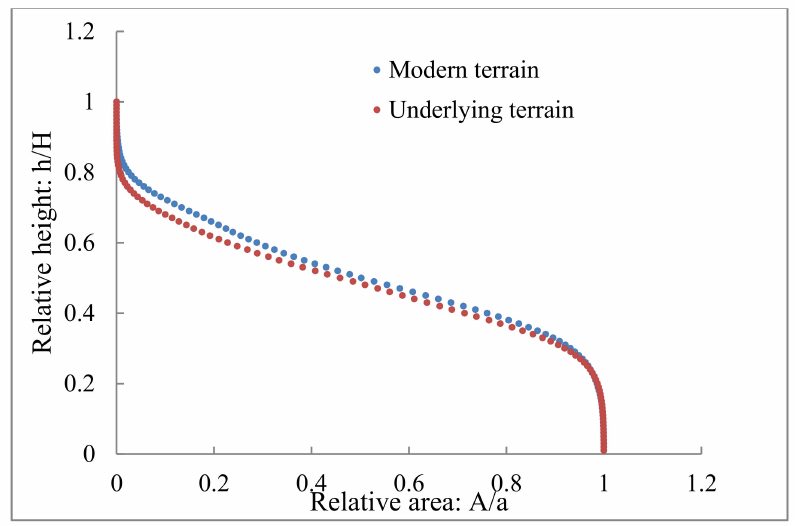
Figure 5. Hypsometric curves for the modern and underlying